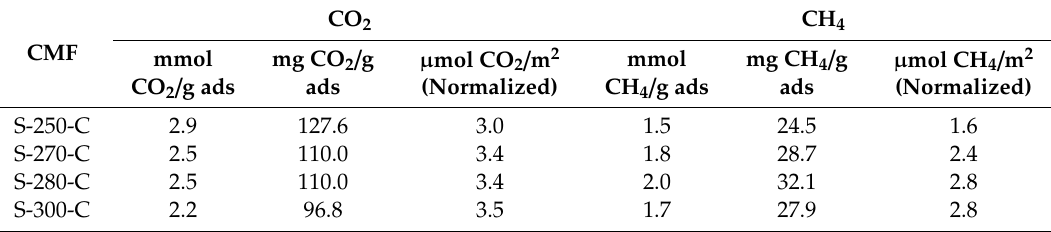
Table 3. CO 2 and CH 4 adsorption capacity (1 bar, 25 °C) in materials stabilized at 250, 270, 280, and